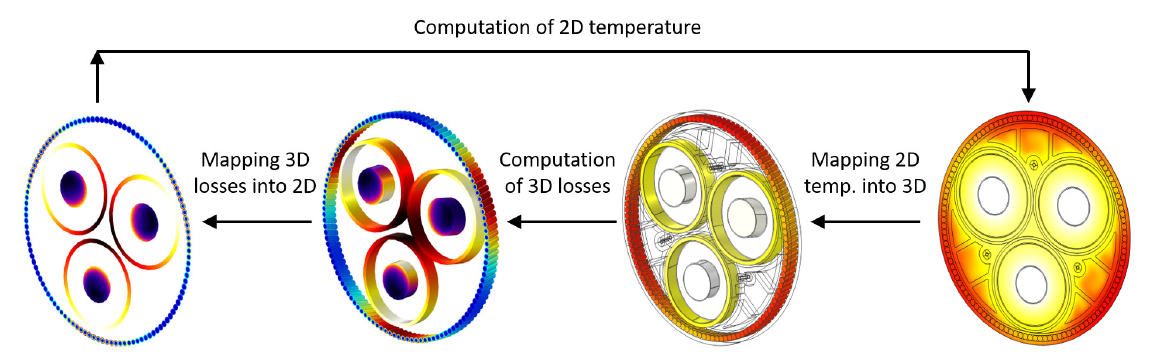
Figure 3. Sequence for mapping magnitudes between 2D and 3D geometries.